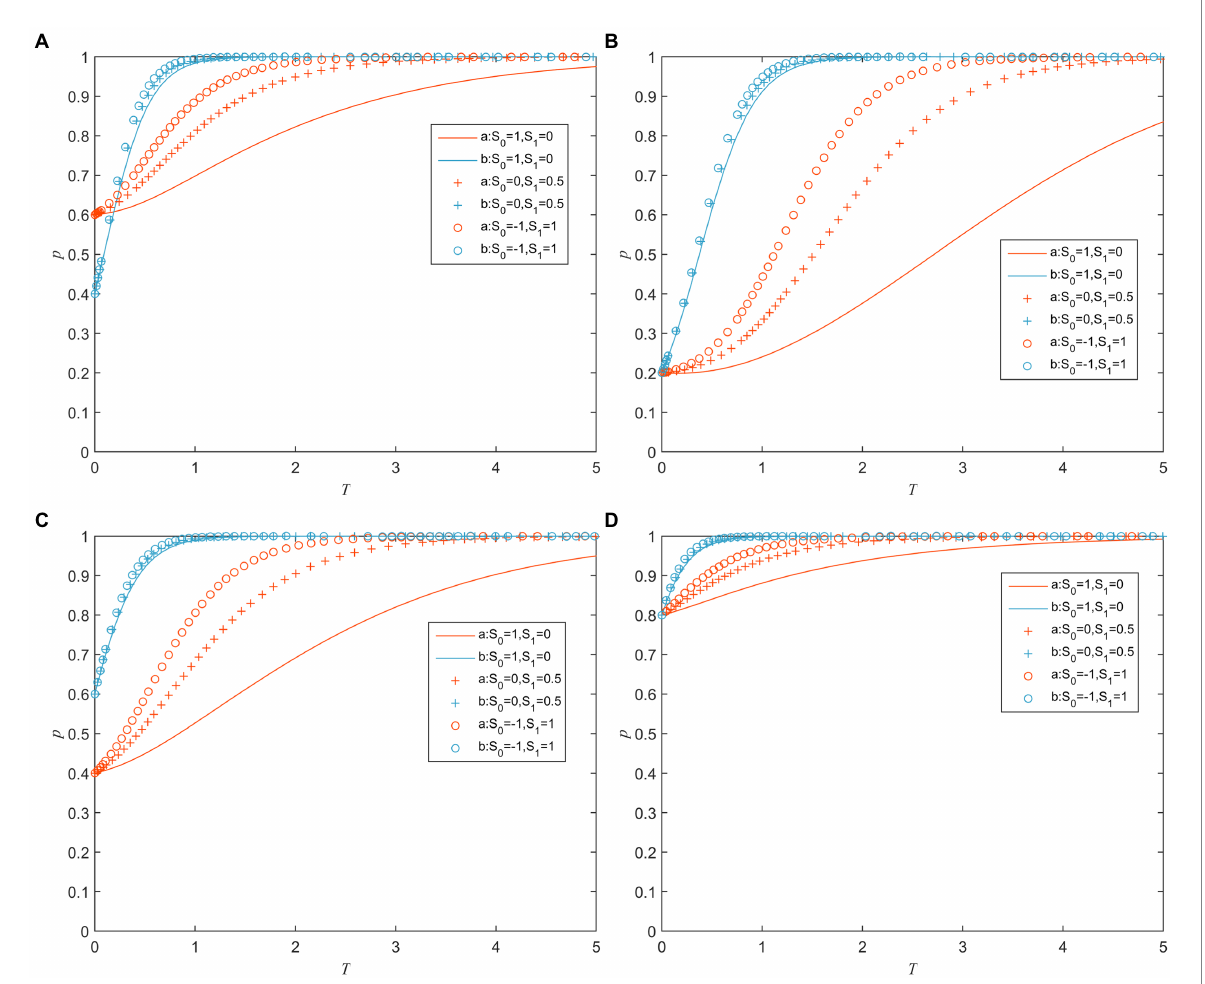
FIGURE 5 Strategy evolution of game players under different values of 0 S and 1 S . (A) a = 0.6 and b = 0.4. (B) a = 0.2 and b = 0.2. (C) a = 0.4 and b = 0.6. (D) a = 0.8 and b =